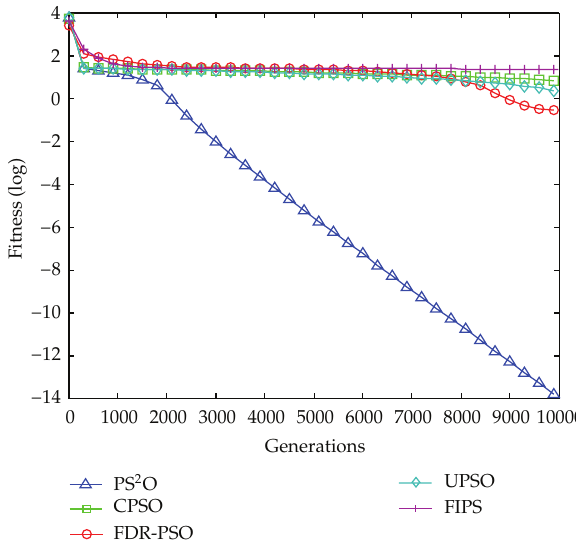
Figure 6: The median convergence results of Rosenbrock